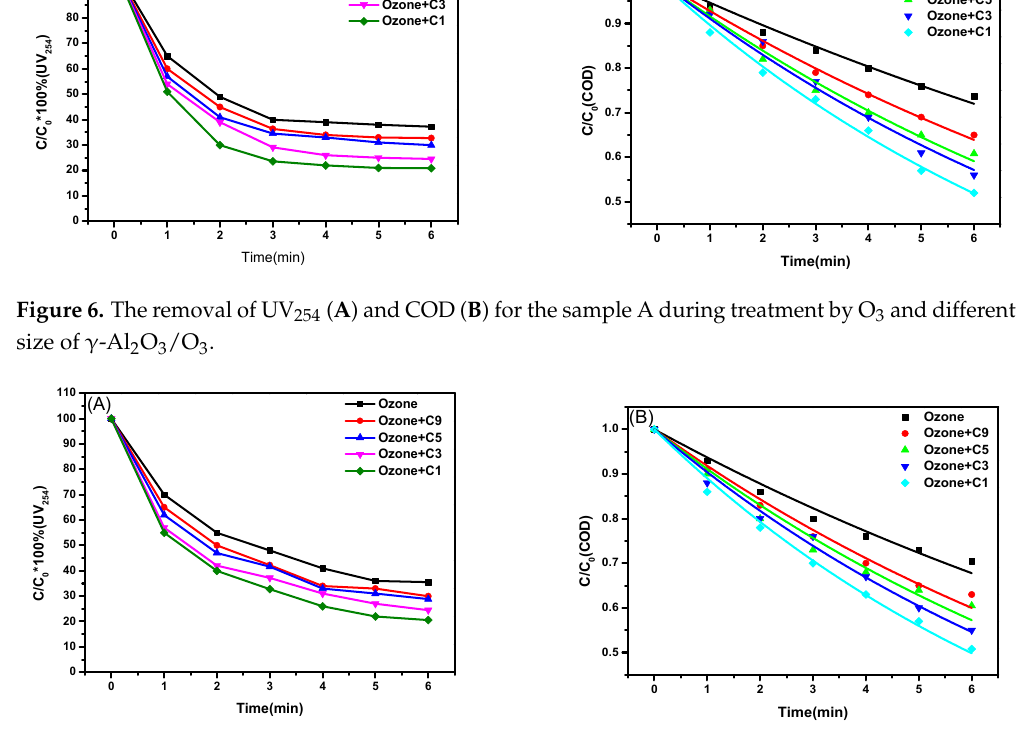
Figure 7. The removal of UV 254 ( A ) and chemical oxygen demand (COD) ( B ) for the sample B during treatment by O 3 and different size of γ -Al 2 O 3 /O 3 .